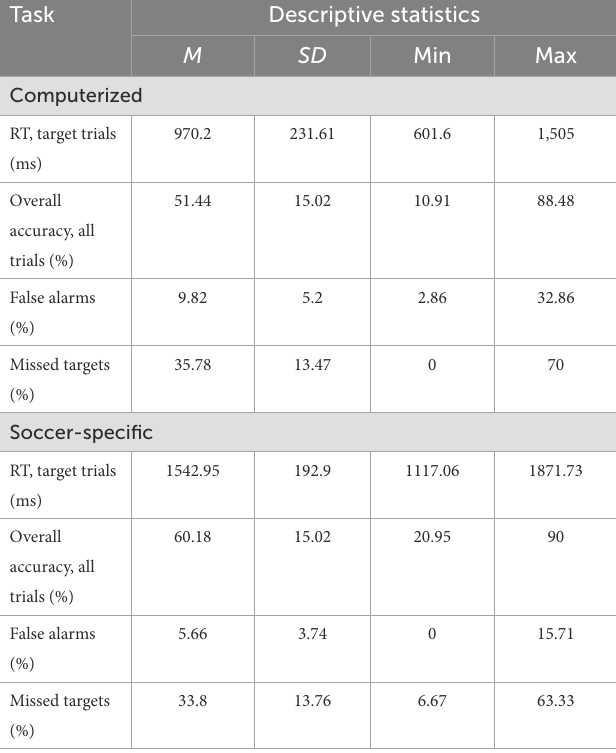
TABLE 2 Descriptive statistics for the general, computerized, and soccer- specific versions of the tasks measuring working memory ( n = 57). Task